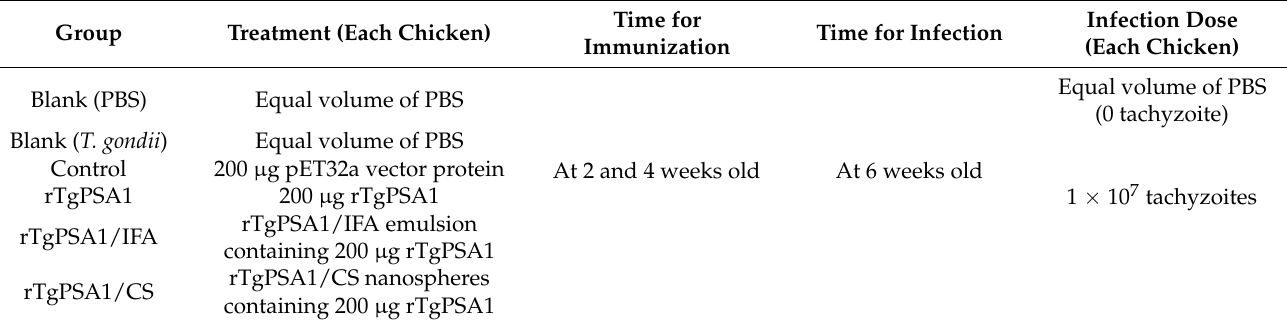
Table 2. Immunization formulations in different chicken